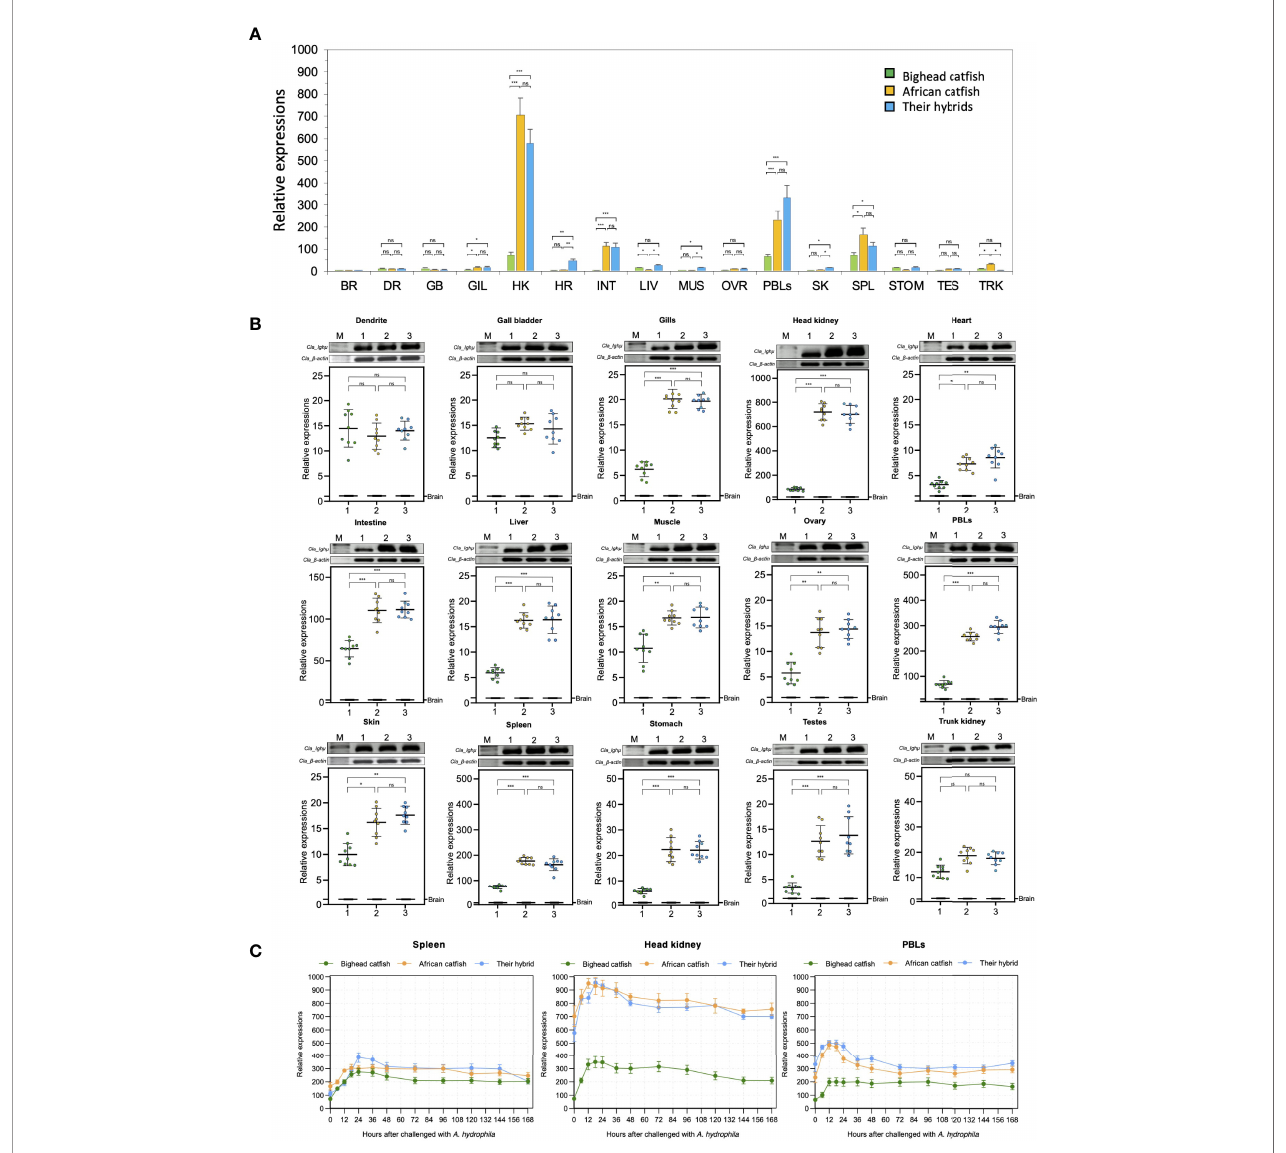
FIGURE 6 | Representation of the overall relative expression and distribution of Igh m in bighead cat fi sh, North African cat fi sh and their hybrid cat fi sh in sixteen tissues (A) . Comparison of the relative expression of Igh m in sixteen different tissues (B) . Expression responses of Igh m in immune-related organs, including the spleen, head kidney and PBLs, after intraperitoneal injection of a virulent pathogen, Aeromonas hydrophila , of bighead cat fi sh, North African cat fi sh and their hybrid cat fi sh (C) . The relative expression levels of Igh m genes were calculated using b -actin as a reference gene. All quantitative data are presented as the mean ± standard deviation (SD). The levels of statistical signi fi cance are indicated by *( P <0.05), **( P <0.01) or ***( P <0.001). The brain RT was used as the calibrator. All experiments are done in triplicate (n = 3). ns, not signi fi